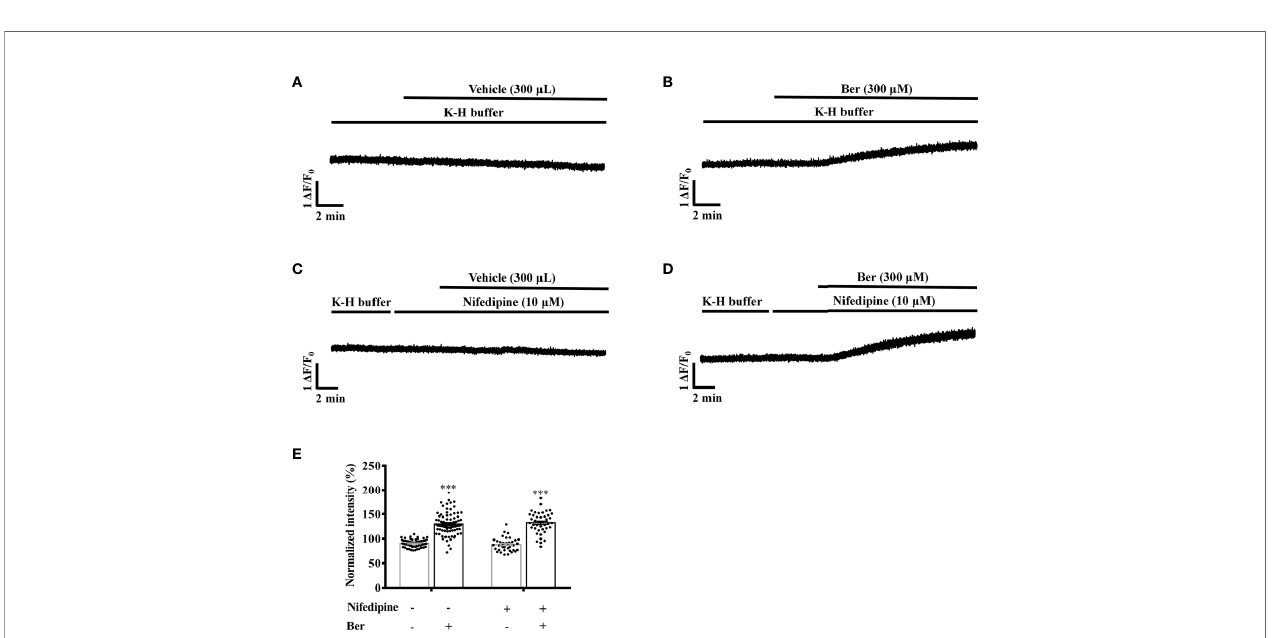
FIGURE 10 | Nifedipine did not in fl uence the 300 m M berberine-induced increase in the intracellular Ca 2+ level of freshly isolated left ventricular (LV) myocytes. (A – D) Original Ca 2+ imaging recordings of the LV myocytes treated with vehicle (A) , 300 m M Ber (B) , 10 m M nifedipine (C) and 300 m M Ber in the presence of 10 m M nifedipine (D) . (E) Summary data showing nifedipine did not affect the 300 m M berberine-induced increase in the intracellular Ca 2+ level of LV myocytes. The numbers of repeats are as follows: vehicle control of 300 µM Ber, n = 57, N = 4; 300 µM Ber, n = 83, N = 4; 10 m M nifedipine, n = 37, N = 4; 300 µM Ber plus 10 m M nifedipine, n = 46, N = 4; n and N are the numbers of LV myocytes and rats, respectively. Ber stands for berberine. ***p < 0.001 vs. vehicle control group; two-way ANOVA with Tukey's multiple comparisons